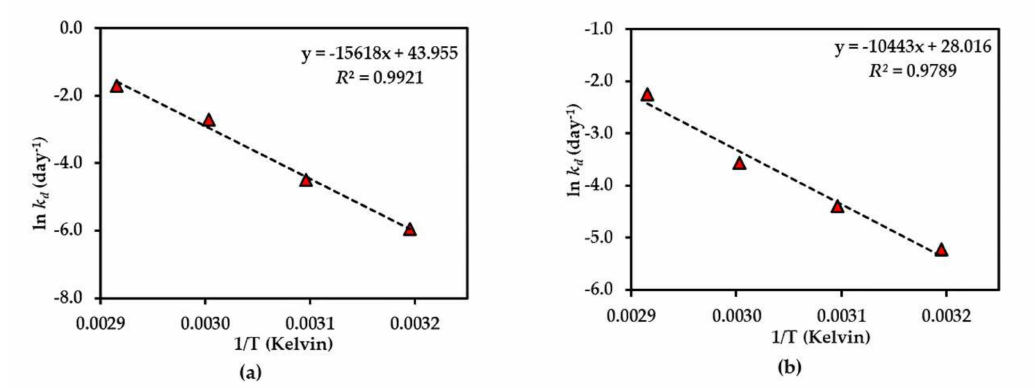
Figure 5. Arrhenius plot for thermal degradations of compound 1 in ( a ) dried AE and ( b ) AE solution over the temperature range 40 ◦ C–70 ◦ C. The plotted points are mean ± SD ( n =